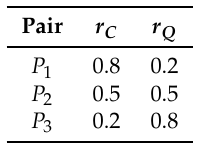
Table 3. Chosen weight pairs.